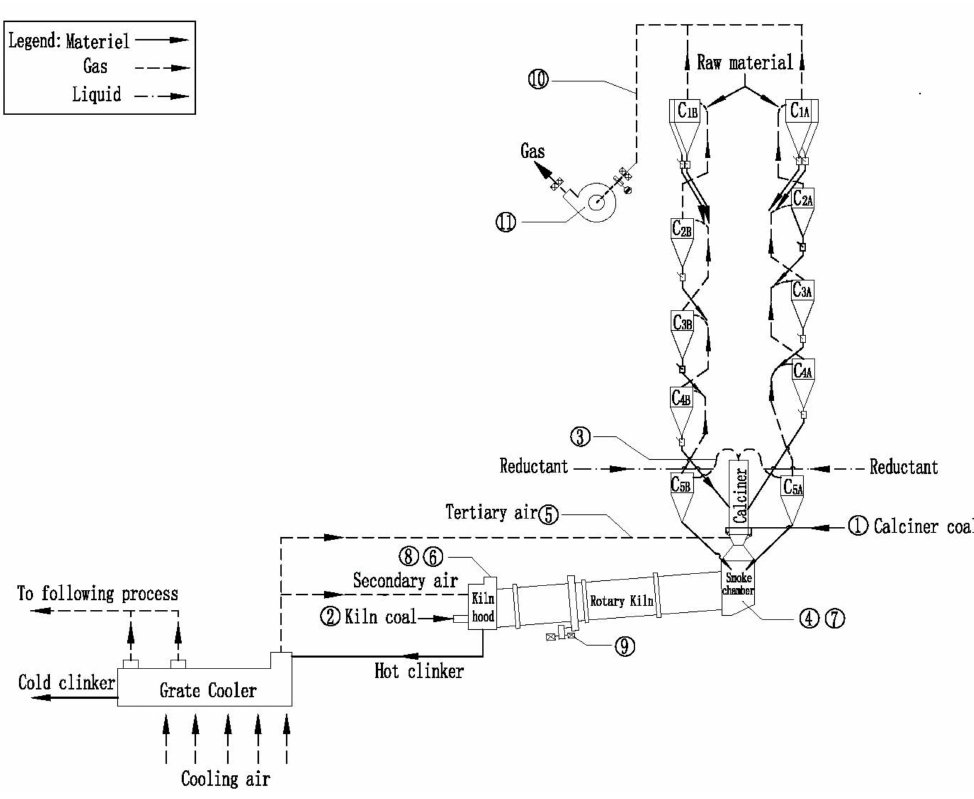
Figure 1. Flow chart of cement clinker burning